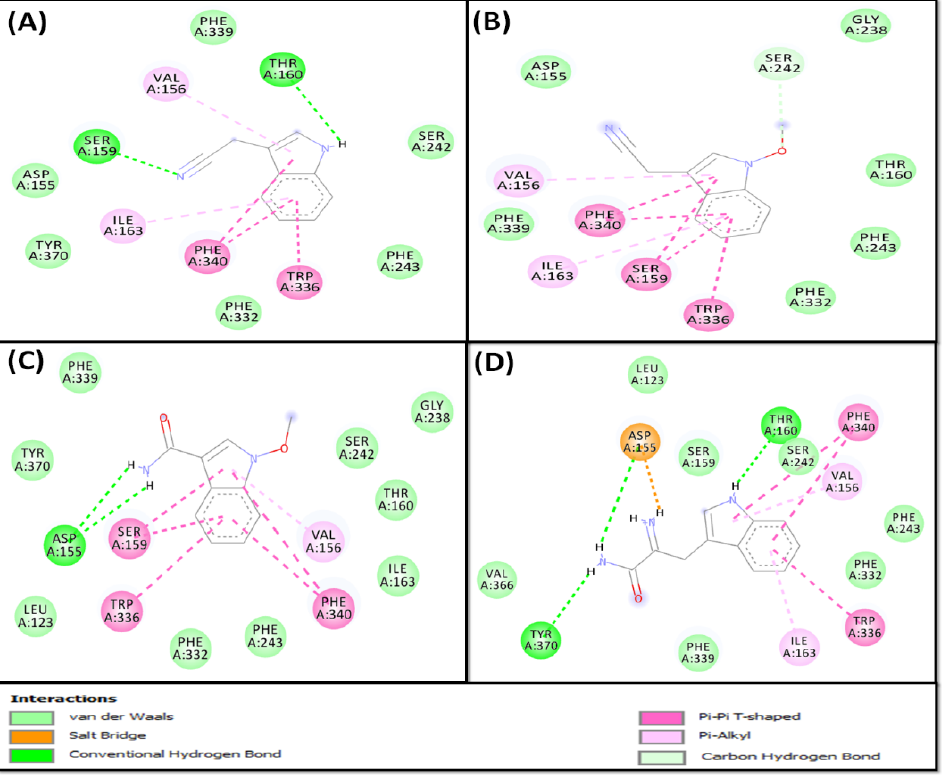
Figure 8. Molecular interaction between S. irio compounds and 5-HT 2A . ( A ) Compound 5 , ( B ) com- pound 6 , ( C ) compound 7 , and ( D ) compound 8